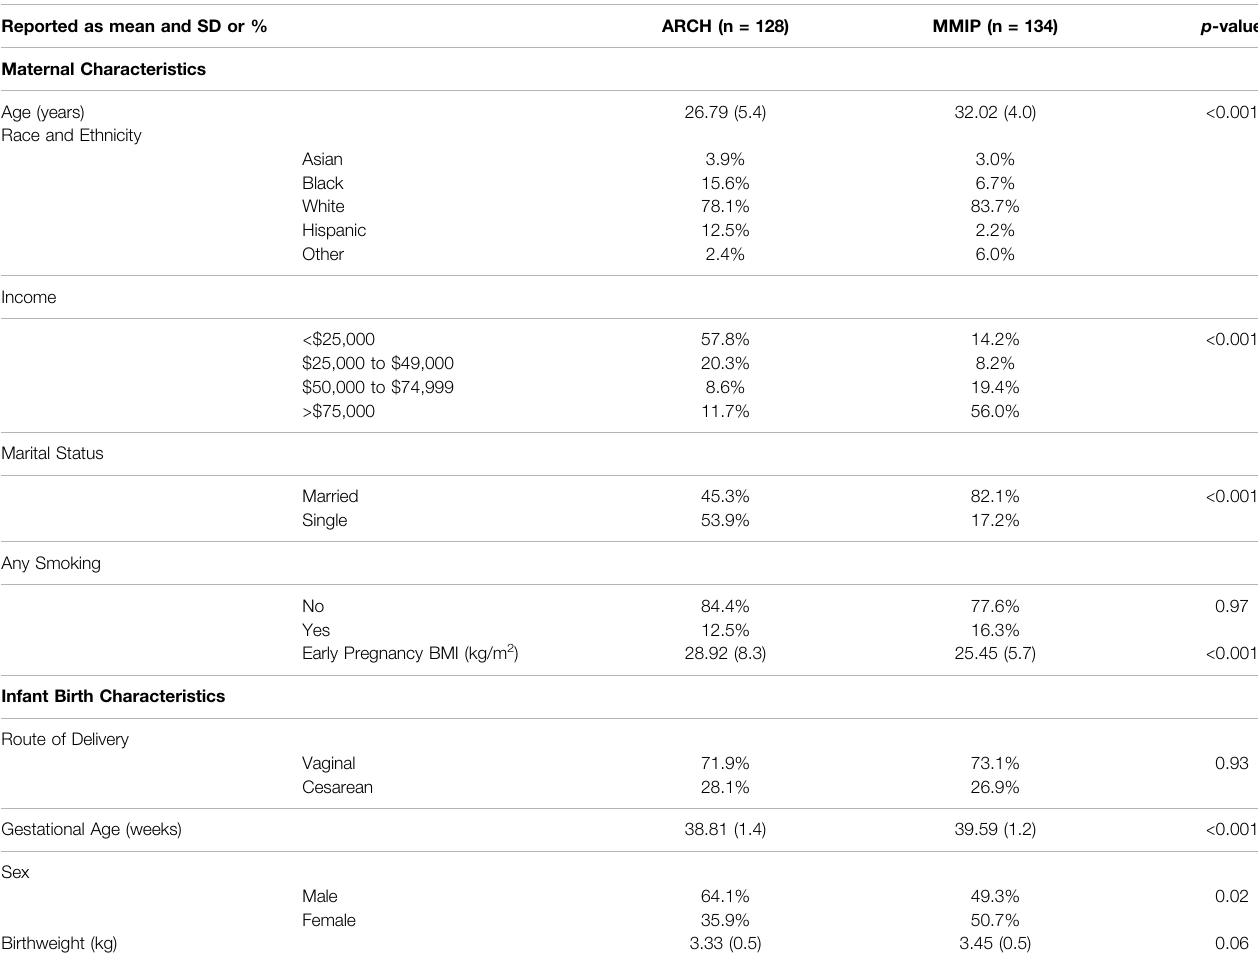
TABLE 2 | Summary of cohort demographics. Reported as mean and SD or